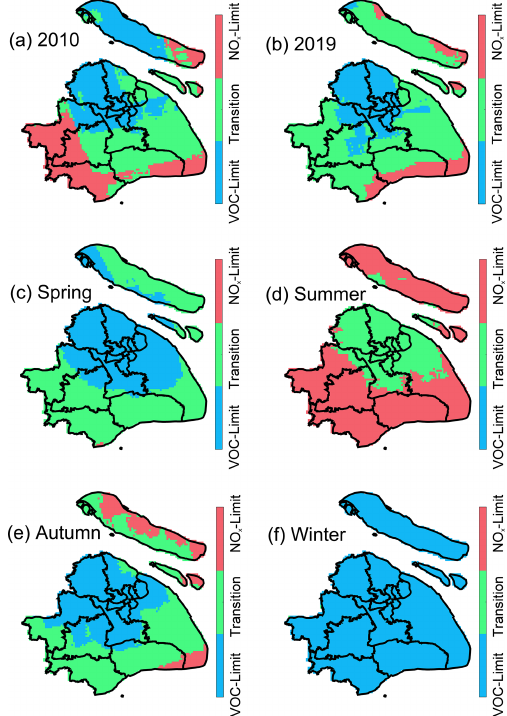
Figure 6. The spatial distribution of FNR SAT for (a) 2010, (b) 2019, and (c–f) different seasons in Shanghai.